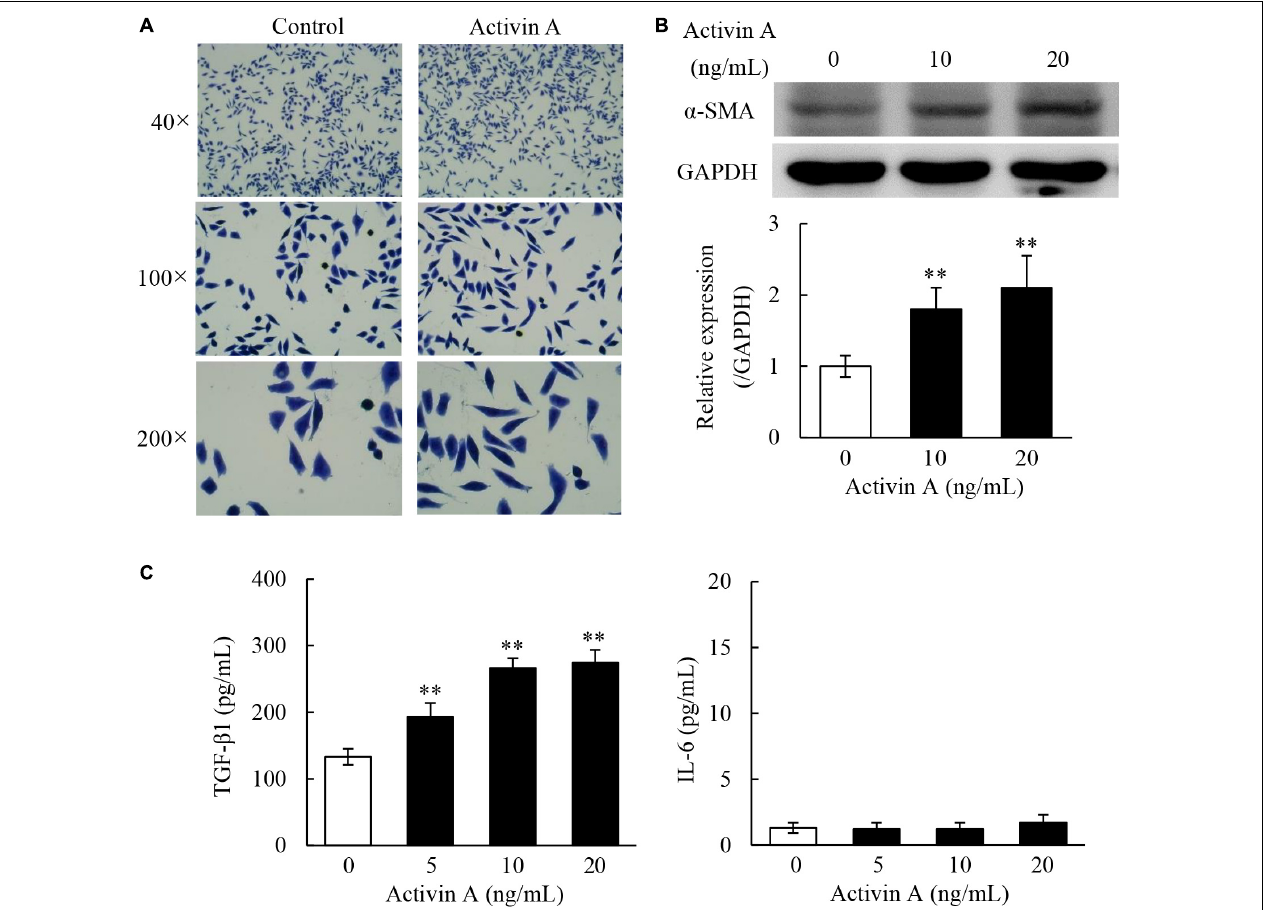
FIGURE 4 | Pro-fibrosis role of activin A in L929 cells. (A) Representative images of L929 cells by Giemsa staining. L929 fibroblasts were treated with or without 10 ng/mL activin A for 24 h. (B) Western blotting analysis showed that activin A promoted α -SMA expression. The graph represented the relative levels of proteins in three separate experiments. The levels of α -SMA protein were normalized against GAPDH, and the results were shown as the fold-increase of the control. ∗∗ P < 0.01 compared with 0 ng/mL control group. (C) L929 cells were incubated containing 0, 5, 10, or 20 ng/mL activin A for 24 h. Levels of TGF- β 1 and IL-6 in the supernatant of cultured L929 cells were measured by ELISA. Data represent mean ± SD ( n = 6). ∗∗ P < 0.01 compared with 0 ng/mL control